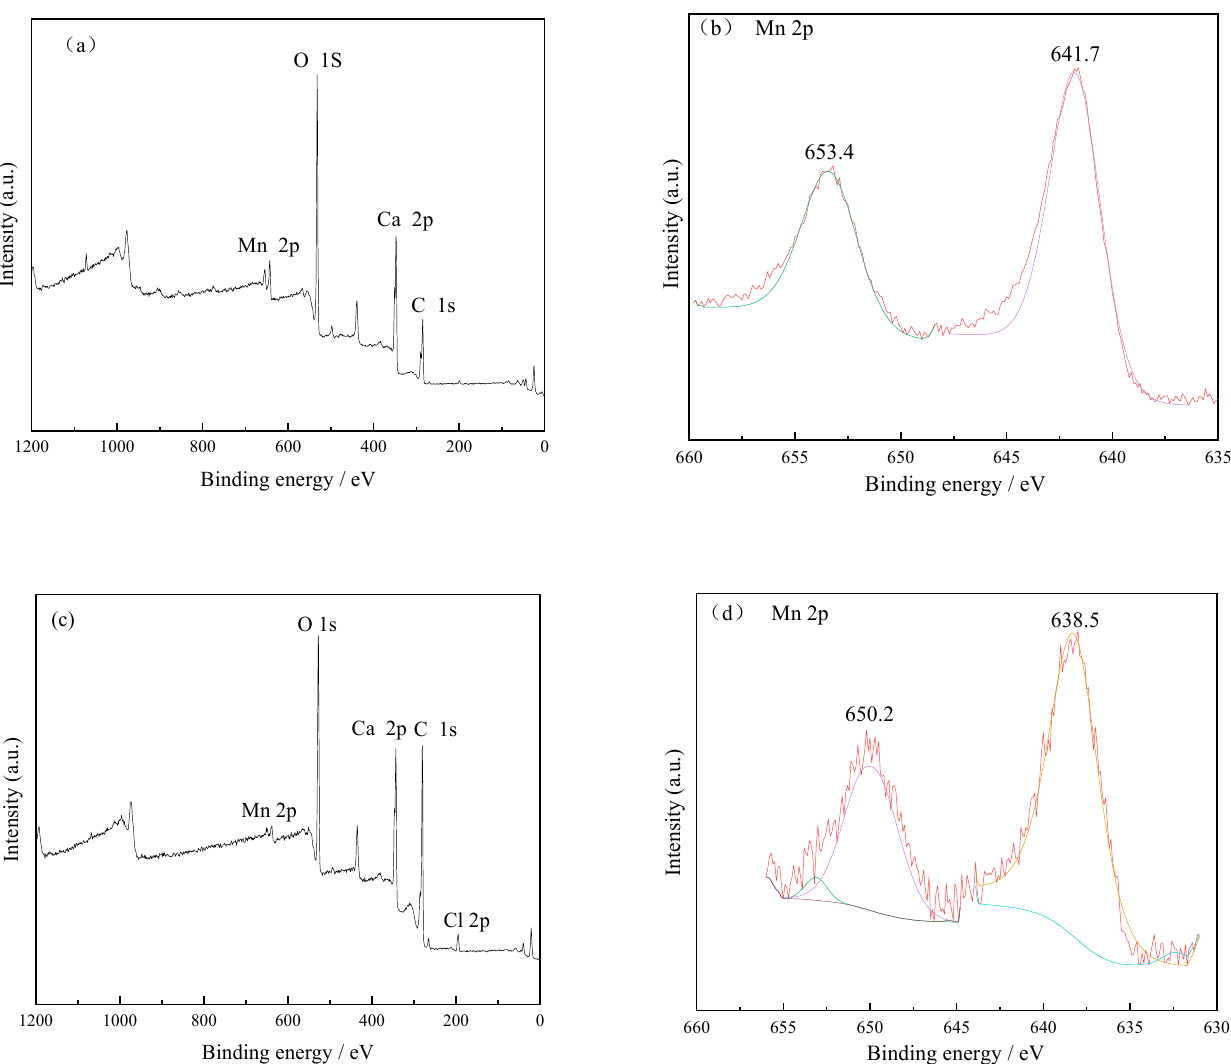
Figure 14. The XPS spectrum of the product of electro-deoxygenation at a voltage of 2.6 V and 3.0 V at 750 °C for 12 h: ( a ) 2.6 V full spectrum ( b ) 2.6 V Mn high-resolution spectrum ( c ) 3.0 V full spectrum ( d ) 3.0 V Mn high-resolution spectrum.